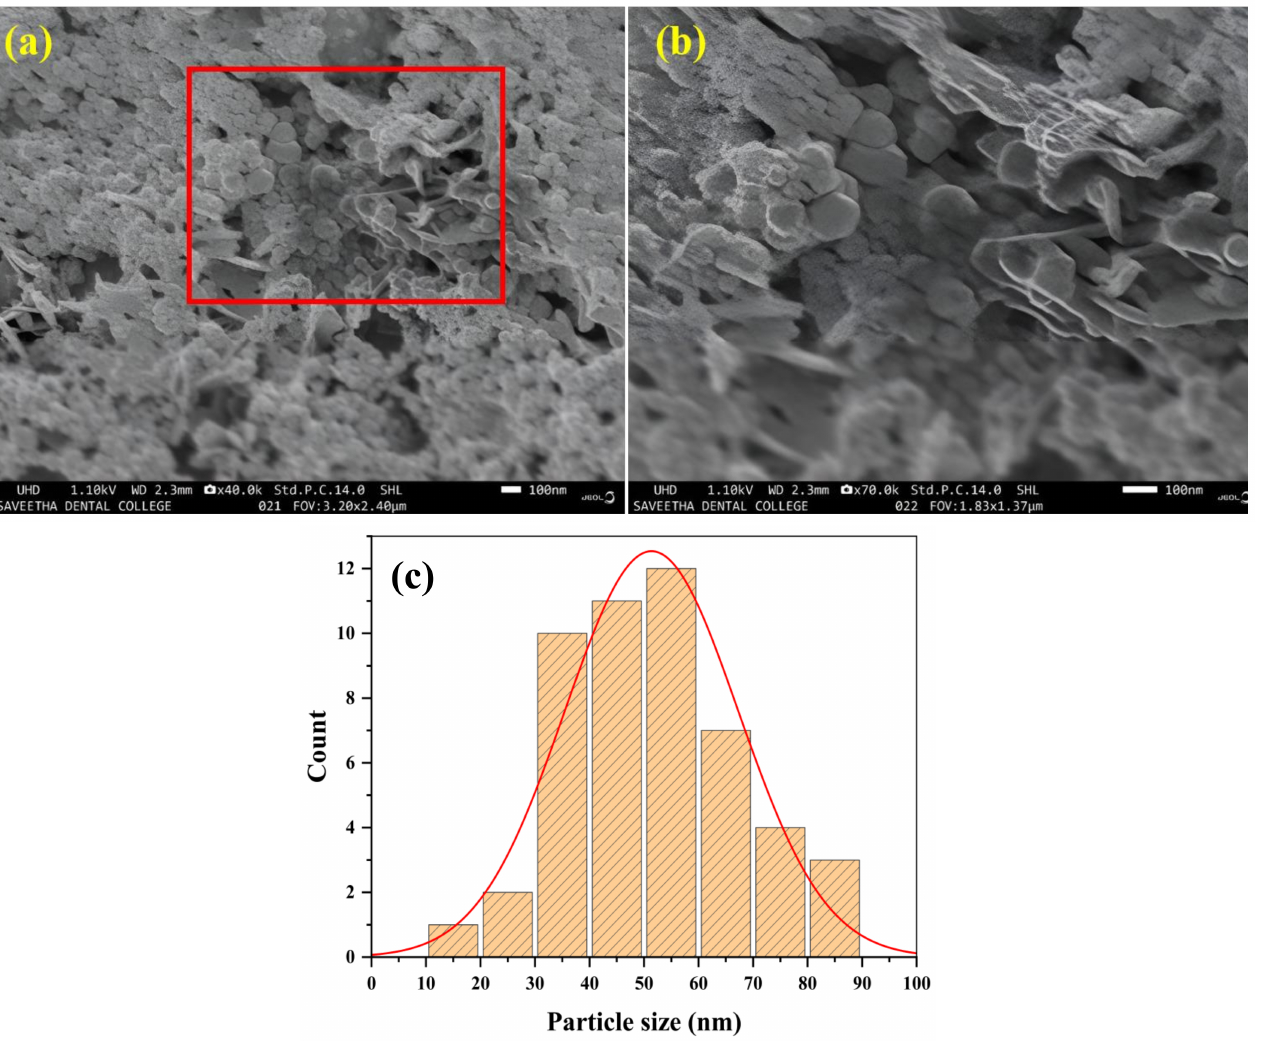
Figure 6. ( a ) FE-SEM images of Ag-NPs prepared using PER fruit extract, ( b ) magnified image of Ag-NPs as shown in red square on image ( a ), and ( c ) particle size distribution of